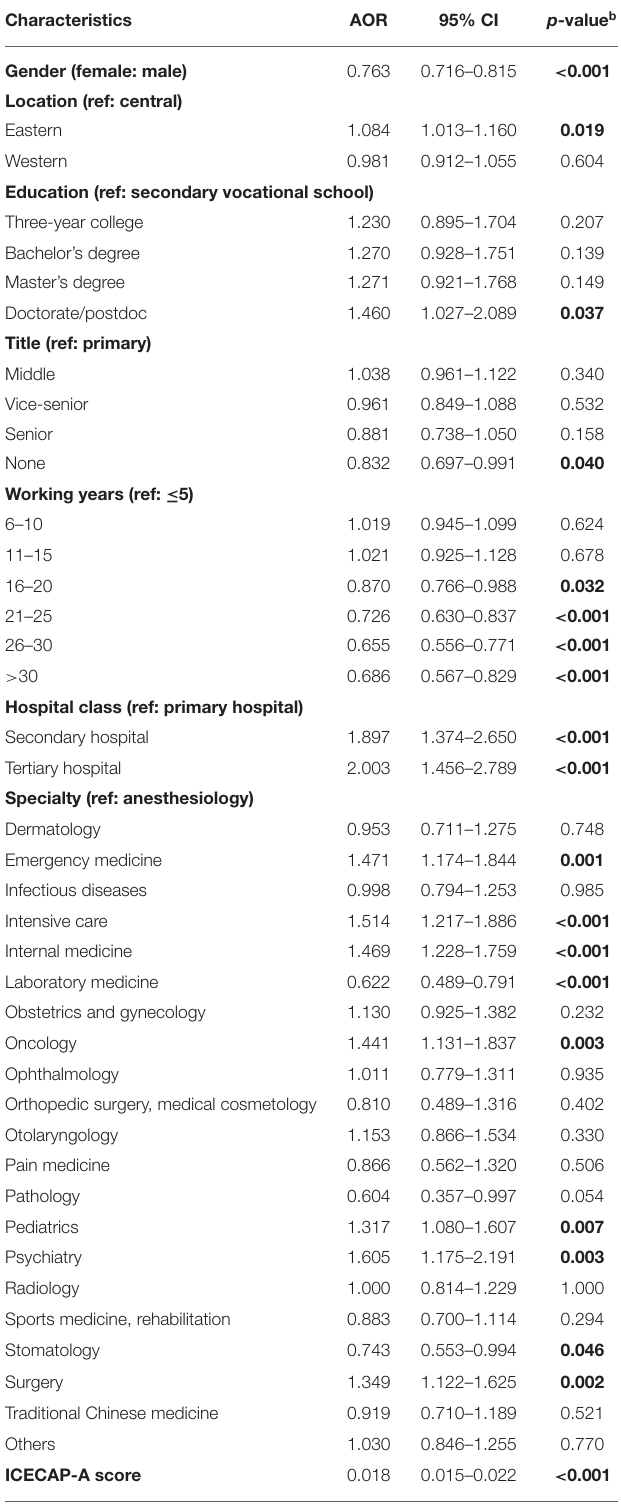
TABLE 5 | Multivariable logistic regression analysis of predictors of high burnout among Chinese medical professionals a .